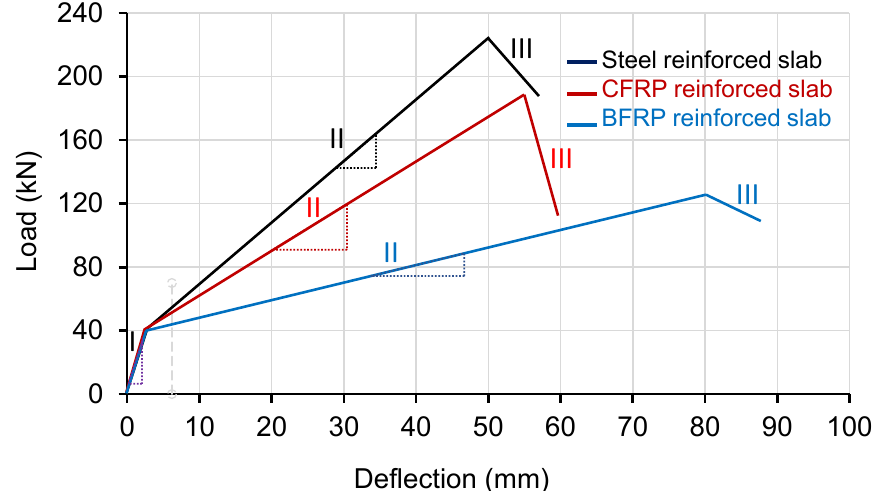
Figure 7. Stiffness of all slabs investigated. Table 3. Stiffness of all test